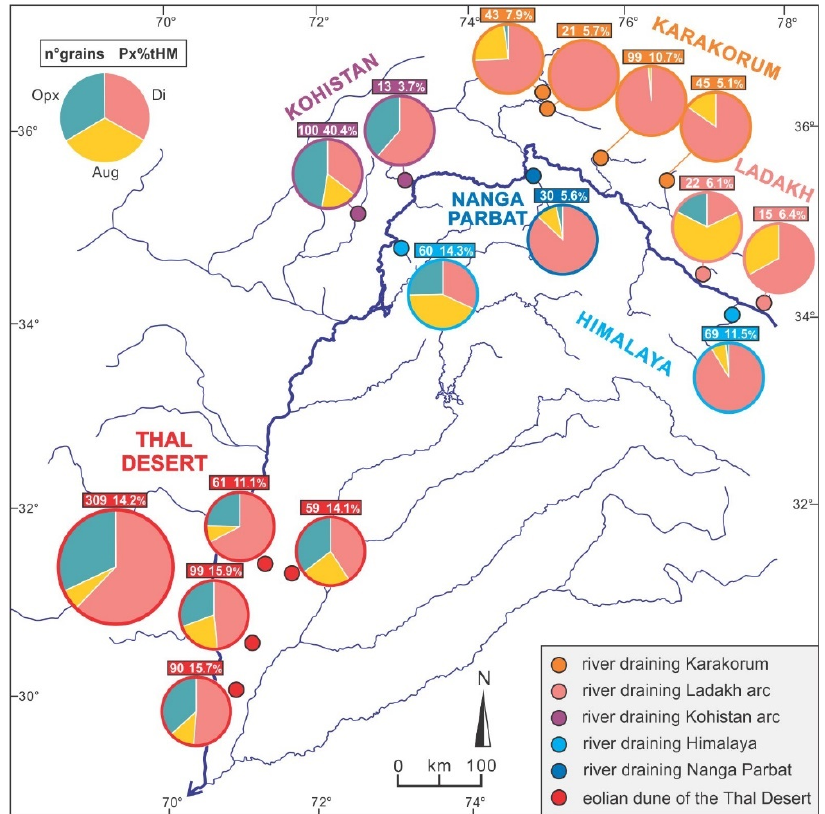
Figure 11. Calculated proportions of different varieties of detrital pyroxene found in river and eolian sands of northern Pakistan. Aug: augite (25 < Wo < 45); Di: diopside (Wo > 45); Opx: orthopyroxene (Wo < 5); Wo: wollastonite.